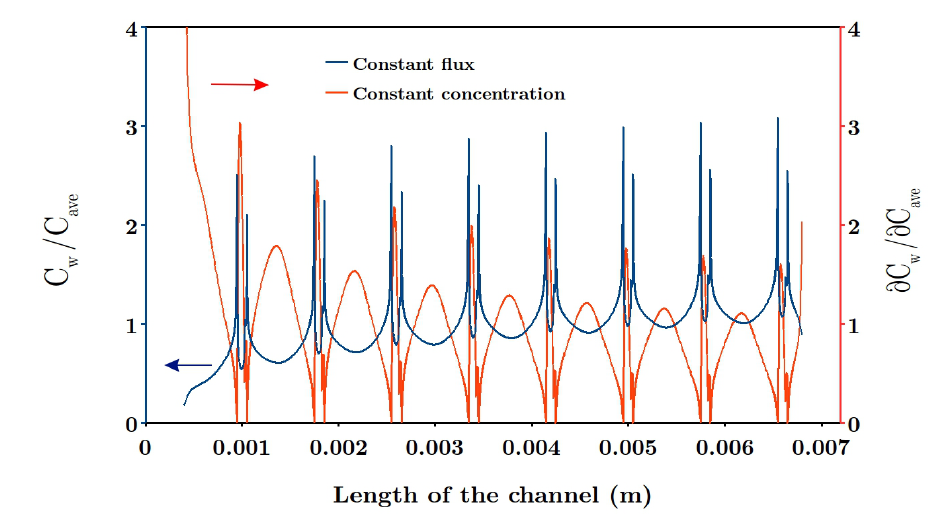
Figure 16. Wall concentration C w obtained from the fixed gradient case normalized to the corresponding constant value used in the fixed concentration case (blue curve, left axis) and concentration gradient at the wall obtained from the fixed concentration case normalized to the corresponding constant value used in the fixed gradient case (red curve, right